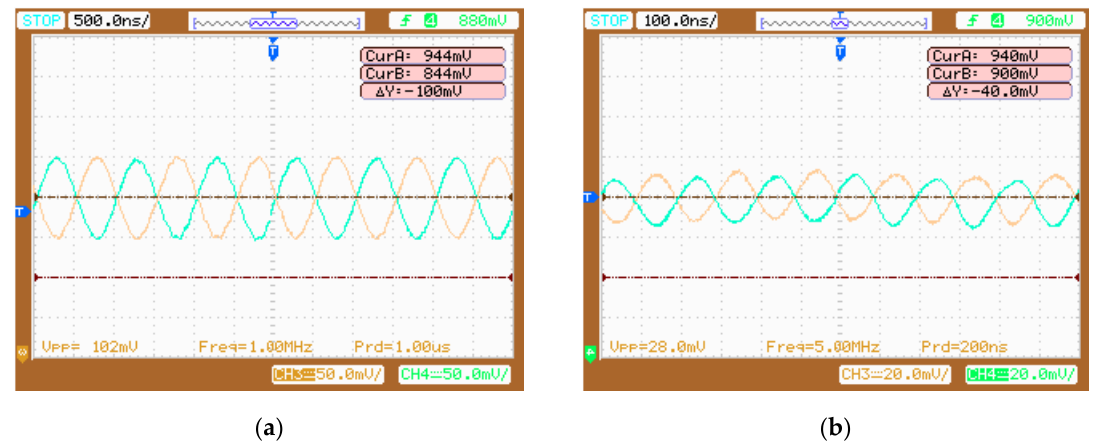
Figure 7. Measured time-domain responses with two single-tone input signals with amplitudes of 100 mVpp and frequencies of ( a ) 1 MHz and ( b ) 5 MHz respectively.